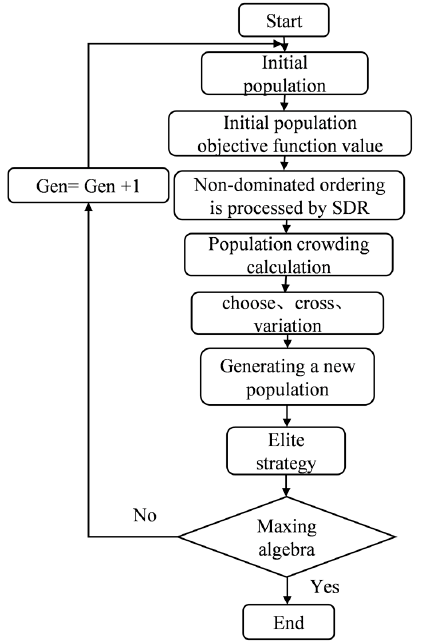
Figure 20. Flow chart of improved NSGA- Ⅱ algorithm.